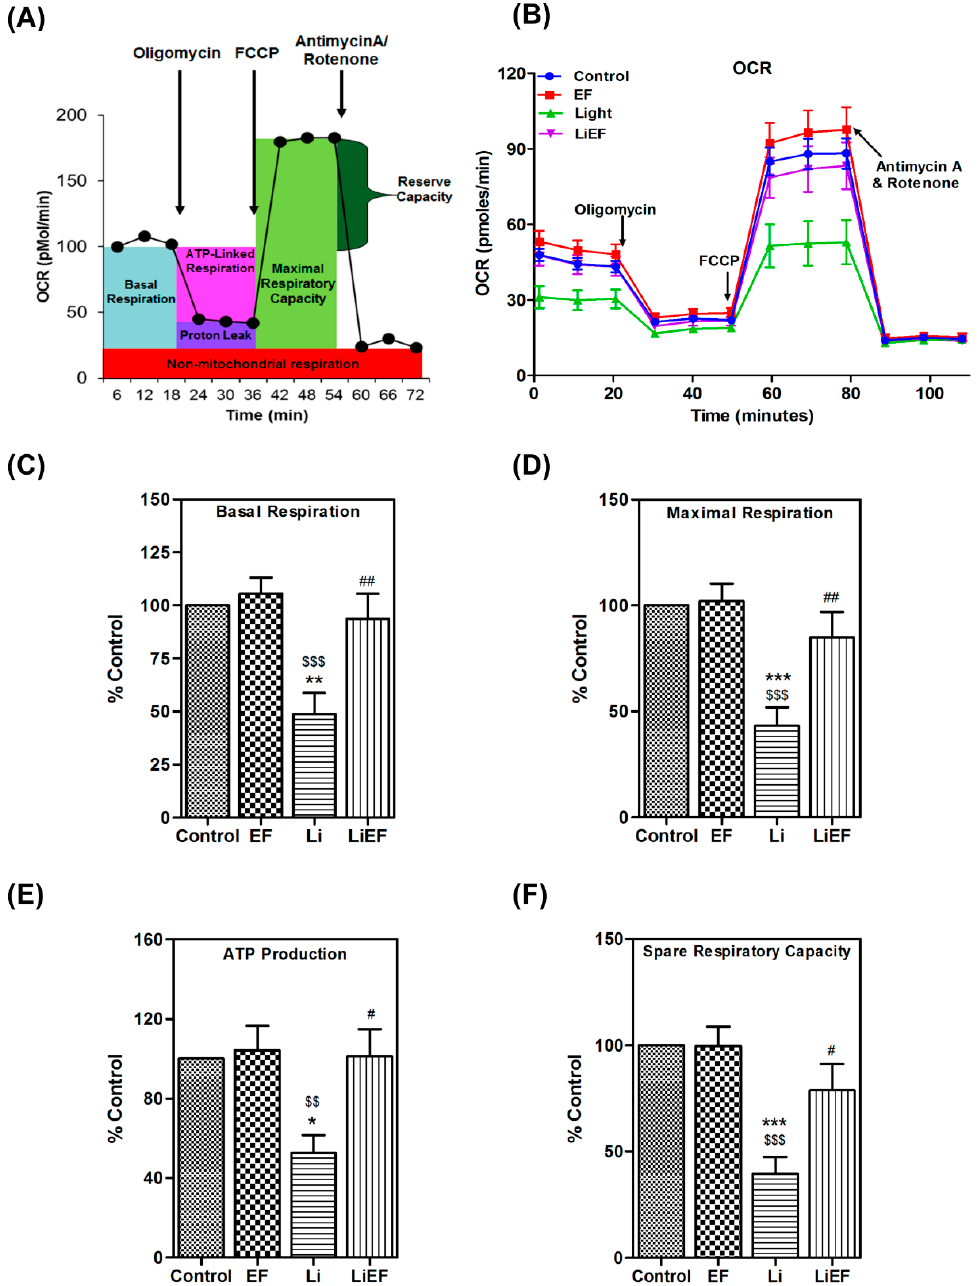
Figure 4. Representative OCR (Oxygen Consumption Rate) bioenergetics profile in 661W cells. ( A )